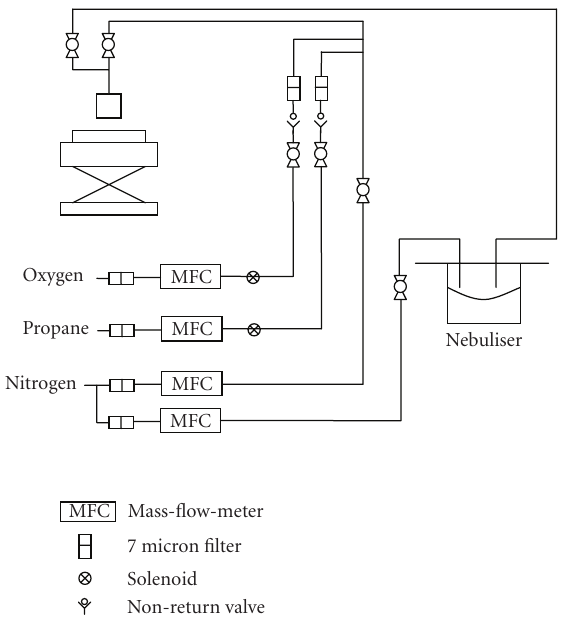
Figure 1: Schematic of the FACVD